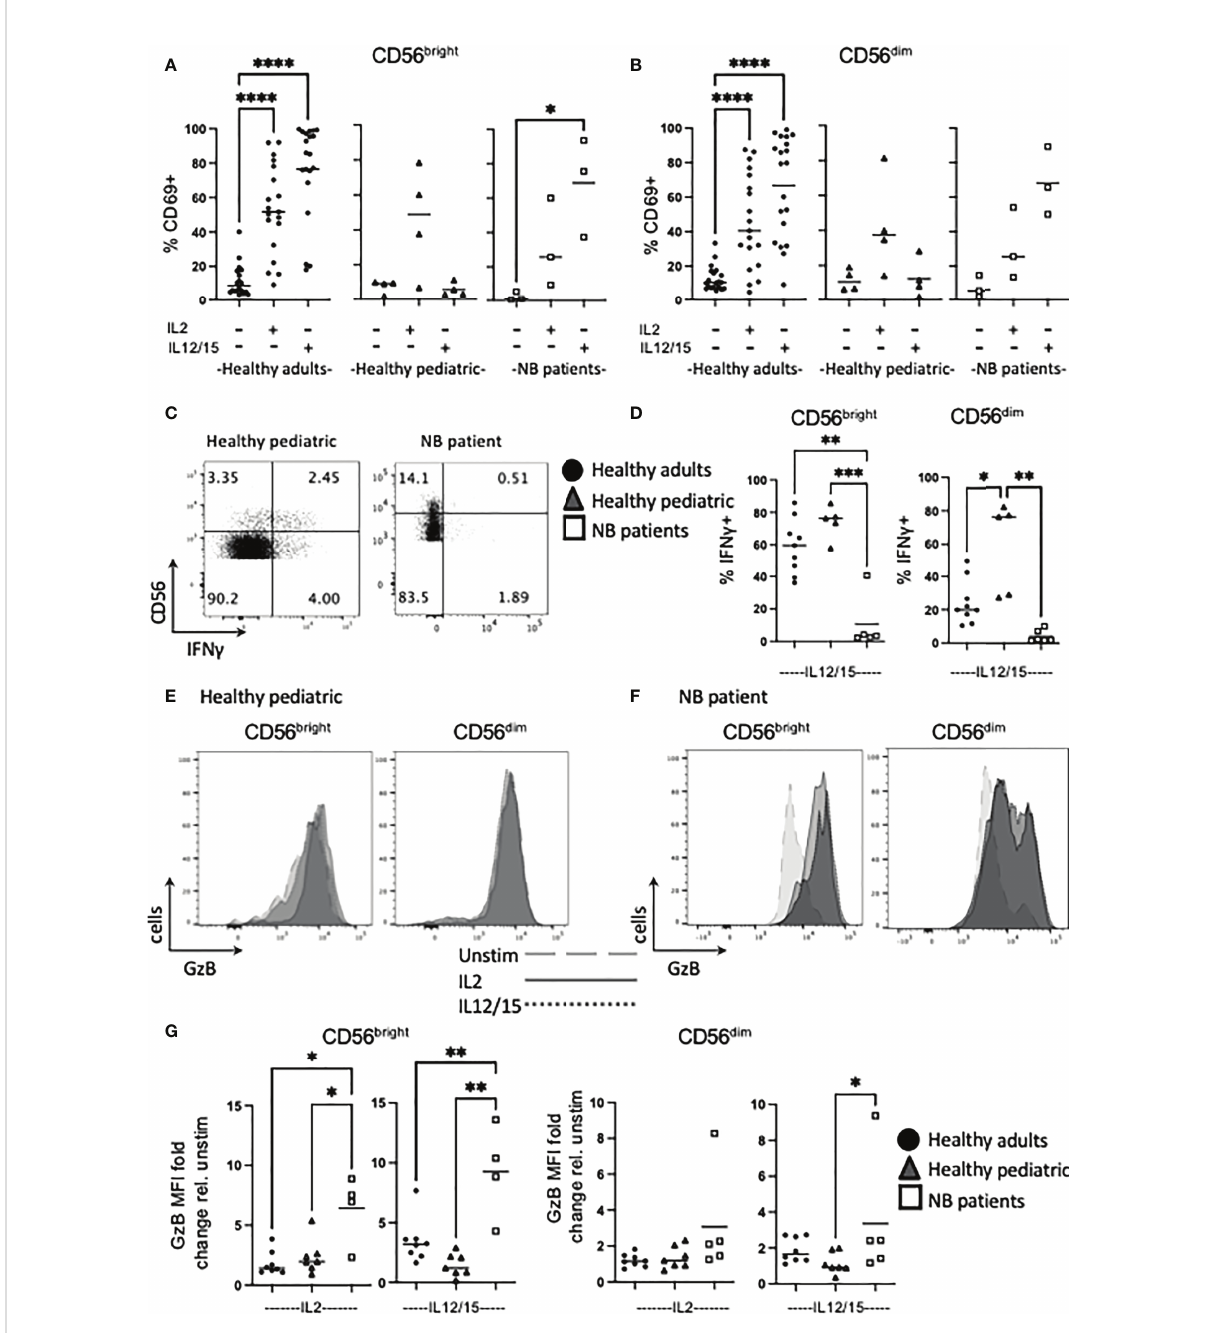
FIGURE 2 Cytokines induce high levels of Granzyme B in NK cells from NB patients. PBMC were isolated from fresh blood of healthy adult donors, healthy pediatric donors and NB patients. Cells were stimulated with IL2 (500 IU/mL) or IL12 (30 ng/mL) and IL15 (100 ng/mL) at 37°C for 18 hours where indicated. (A – G) Cells were stained for CD69, IFN g and granzyme B (GzB) and analyzed by fl ow cytometry. (C, E, F) Figures are representative of pooled data. Dots represent individual donors and horizontal bars show the mean, N=3-20. Samples were compared using the Two-way ANOVA test, *p<0.05, **p<0.01, ***p<0.001,